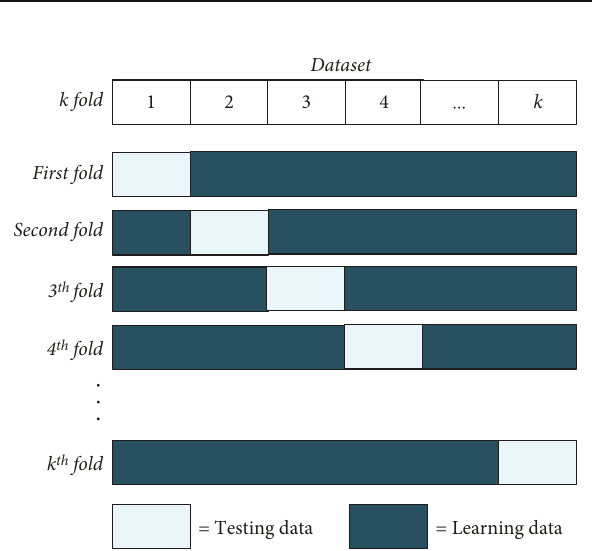
Figure 2: Illustration of data iteration with k -fold